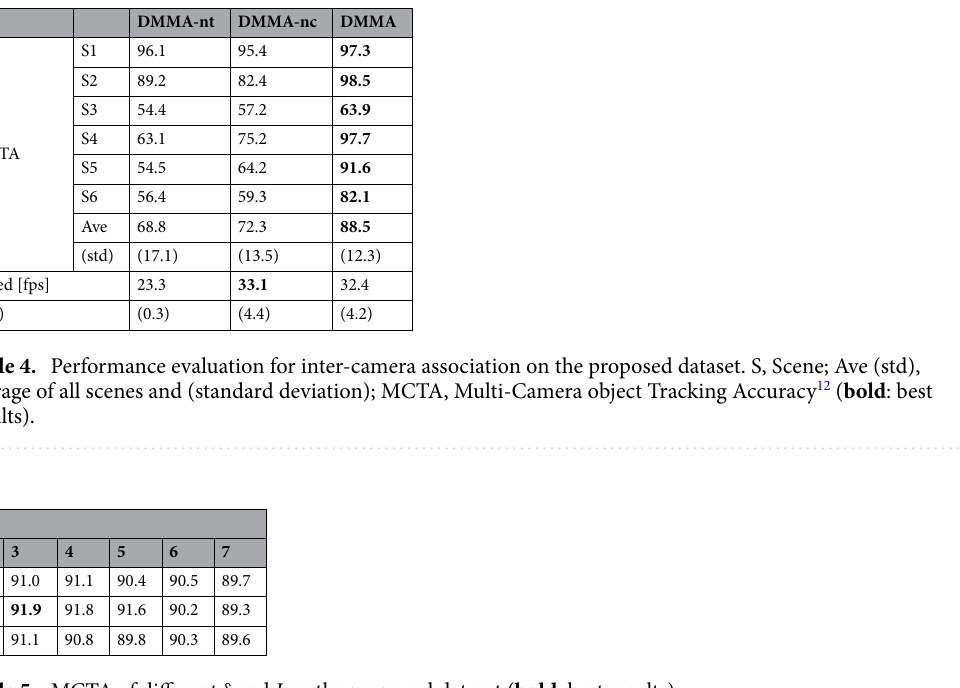
Table 5. MCTA of different δ and J on the proposed dataset ( bold : best